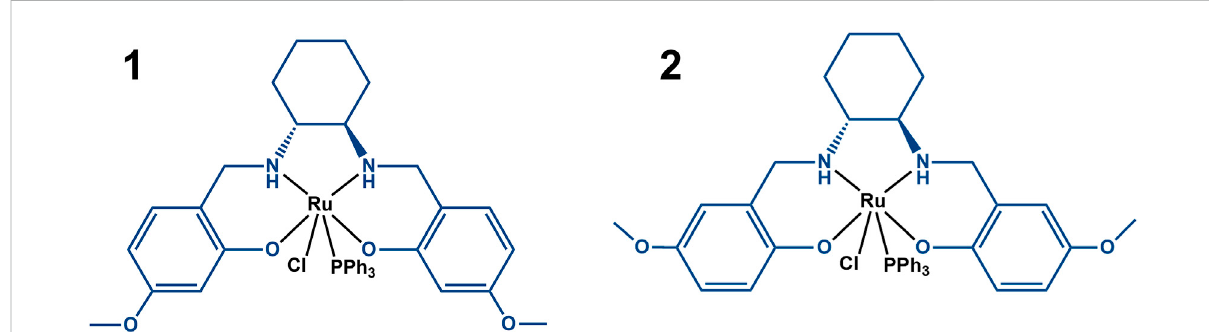
FIGURE 1 Scheme of complexes 1 ([Ru III ( L1) (PPh 3 )Cl]) and 2 {[Ru III ( L2) (PPh 3 )Cl]}, where L1 ≡ [6,6 ′ -(1 R ,2 R )-cyclohexane-1,2-diylbis(azanediyl) bis(methylene)bis(3-methoxyphenol)) and L2 ≡ (2,2 ′ -(1 R ,2 R )-cyclohexane-1,2-diylbis(azanediyl)bis(methylene)bis(4-methoxyphenol)] (both inblue) and PPh 3 is